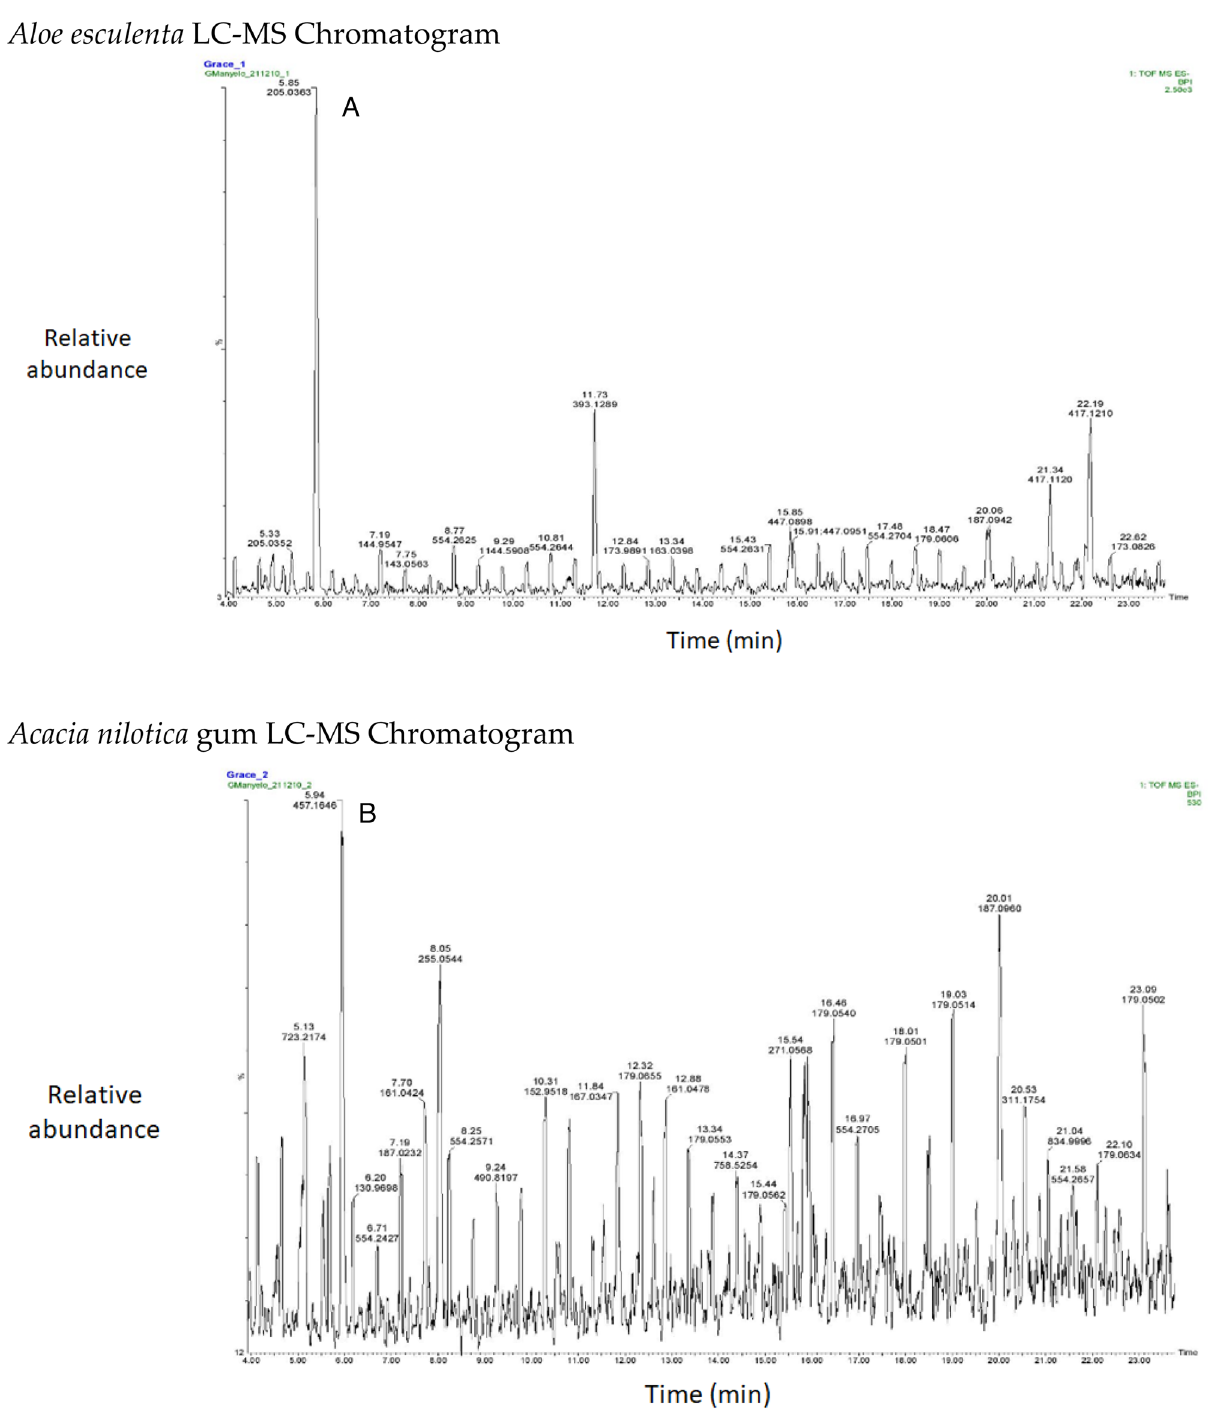
Figure 3. Chromatograms of phenolic compounds in species screened ( A - O ). Aloe esculenta LC–MS Chromatogram . Acacia nilotica gum LC–MS Chromatogram . Acacia nilotica branch LC–MS Chromatogram . Boscia albitrunca tuber LC–MS Chromatogram . Boscia albitrunca leaves LC–MS Chromatogram . Combretum imberbe root extract LC–MS Chromatogram . Colophospermum mopane leaf extract LC–MS Chromatogram . Combretum imberbe leaf extract LC–MS Chromatogram . Colophospermum mopane bark LC–MS Chromatogram . Acacia erioloba bark LC–MS Chromatogram . Fockea angustifolia roots LC–MS Chromatogram .